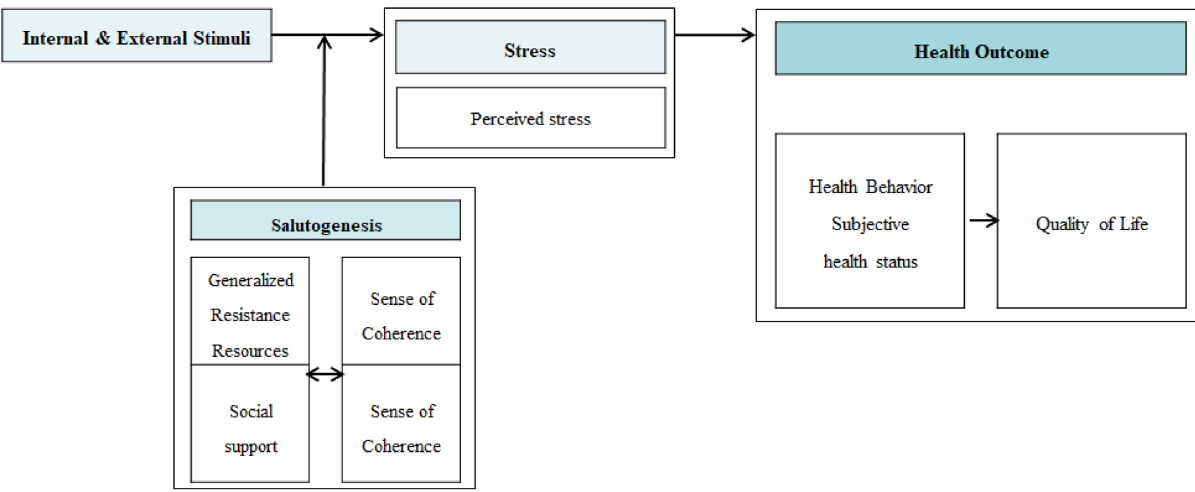
Figure 1. Theoretical framework based on the salutogenesis theory. x1 = social support (parent), x2 = social support (teacher + close friend), x3 = sense of coherence (meaningfulness), x4 = sense of